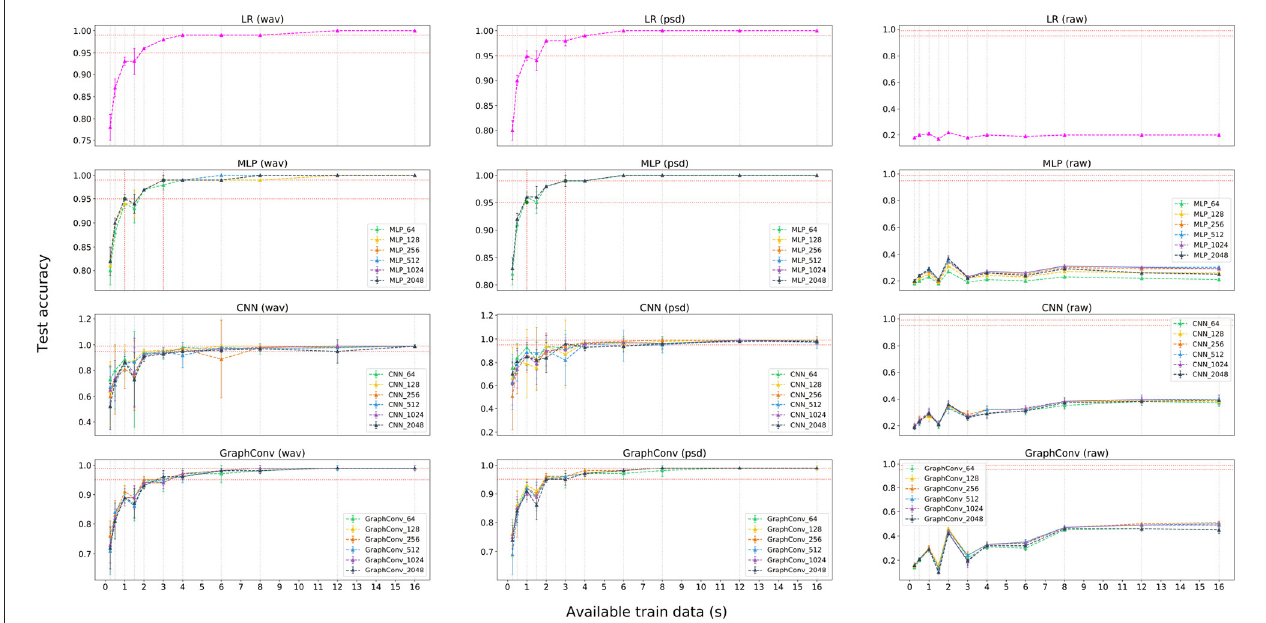
FIGURE 5 | Results visualization for the feature extraction phase. Plots represent test accuracy against available training data for each participant (in seconds). Each row represents one learning approach with a legend accompanying non-linear approaches and displaying the number of hidden channels. Each column represents the employed feature extraction method, considering the raw signal as a baseline for comparison.